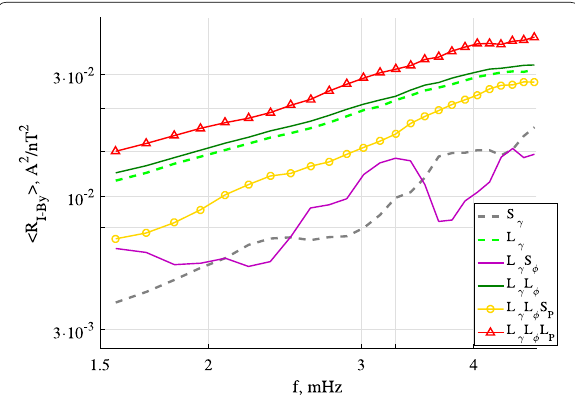
Fig. 10 Averaged R I − By spectra for 6 groups of pulsations: 1)-2) small-scale S γ and large-scale L γ in accordance to the N–S spectral coherence; 3)-4) L γ S ϕ and L γ L ϕ are the small-/large-scale sub-groups of the L γ group defined in accordance to the phase difference; 5)-6) L γ L ϕ S P and L γ L ϕ L P are the small- /large-scale sub-groups of the L γ L ϕ groups defined in accordance to the South-to-North PSD